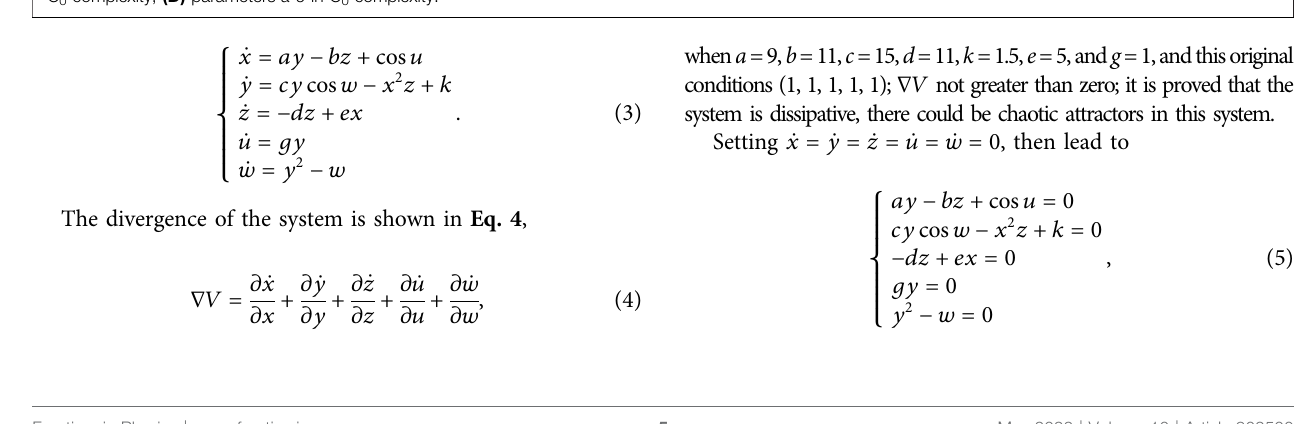
FIGURE9| Complexitydiagramwithdifferentparameter ad and e . (A) Parameters ad inSEcomplexity; (B) parameters ae inSEcomplexity; (C) parameters ad in C 0 complexity; (D) parameters a e in C 0